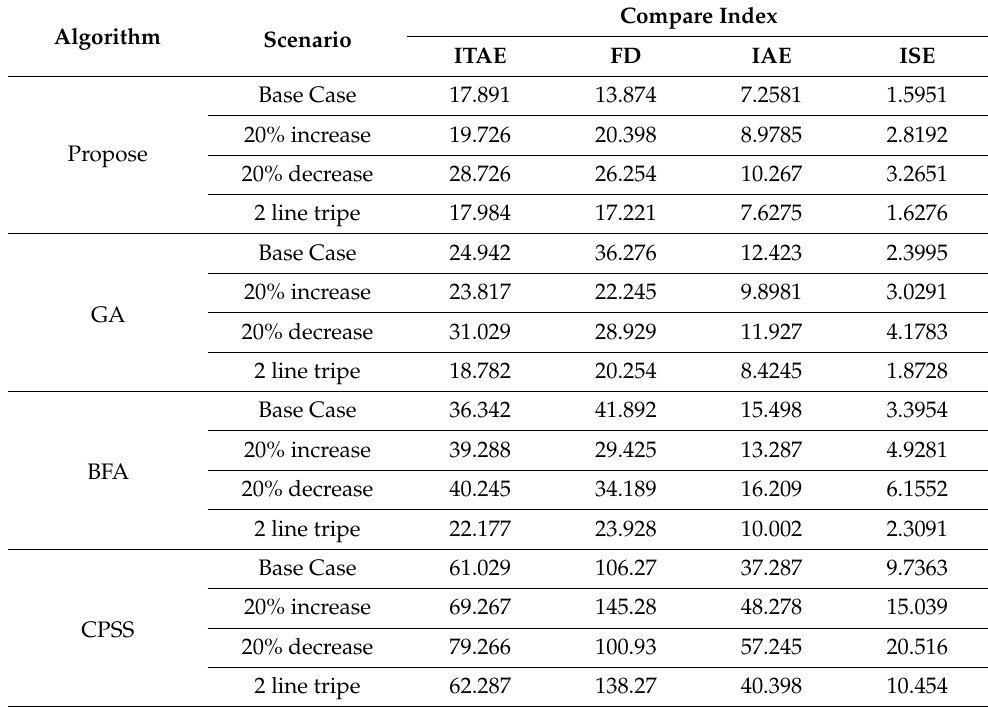
Table 4. The numerical comparison between the proposed methods.